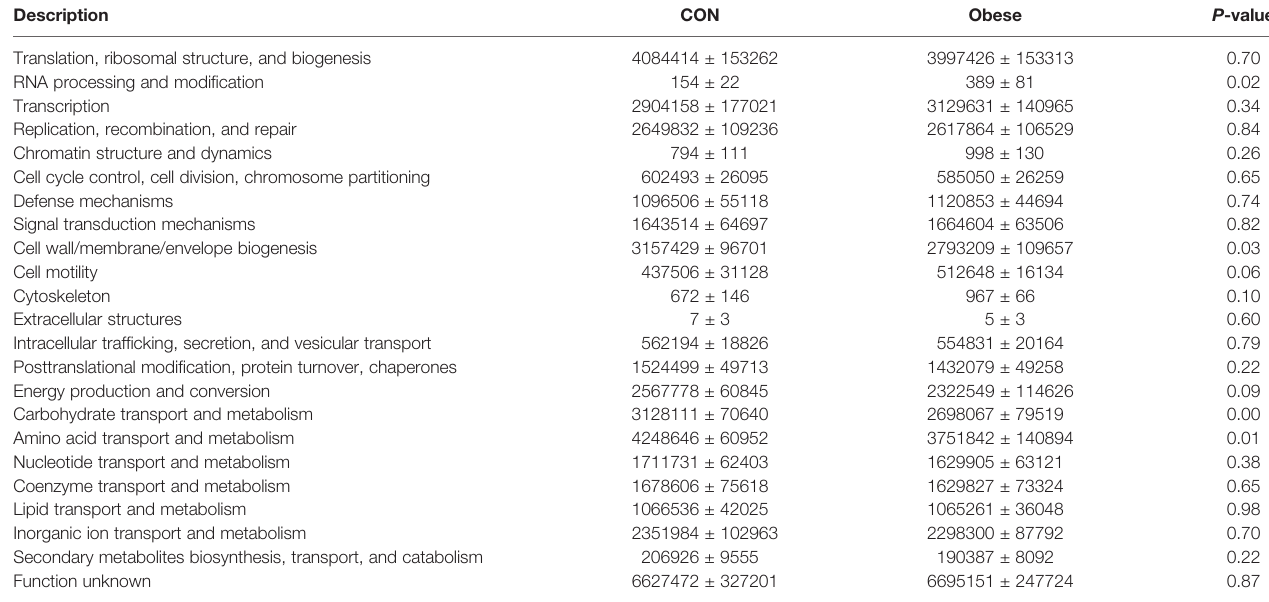
TABLE 1 | PICRUSt analysis of predictive metagenomics function of the fecal microbiota.